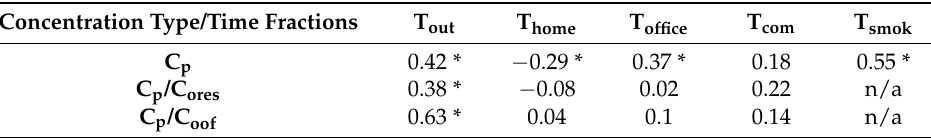
Table 3. Pearson correlation coefficients between personal concentration (C p ) and C p to outdoor concentration levels versus time fractions spent in each